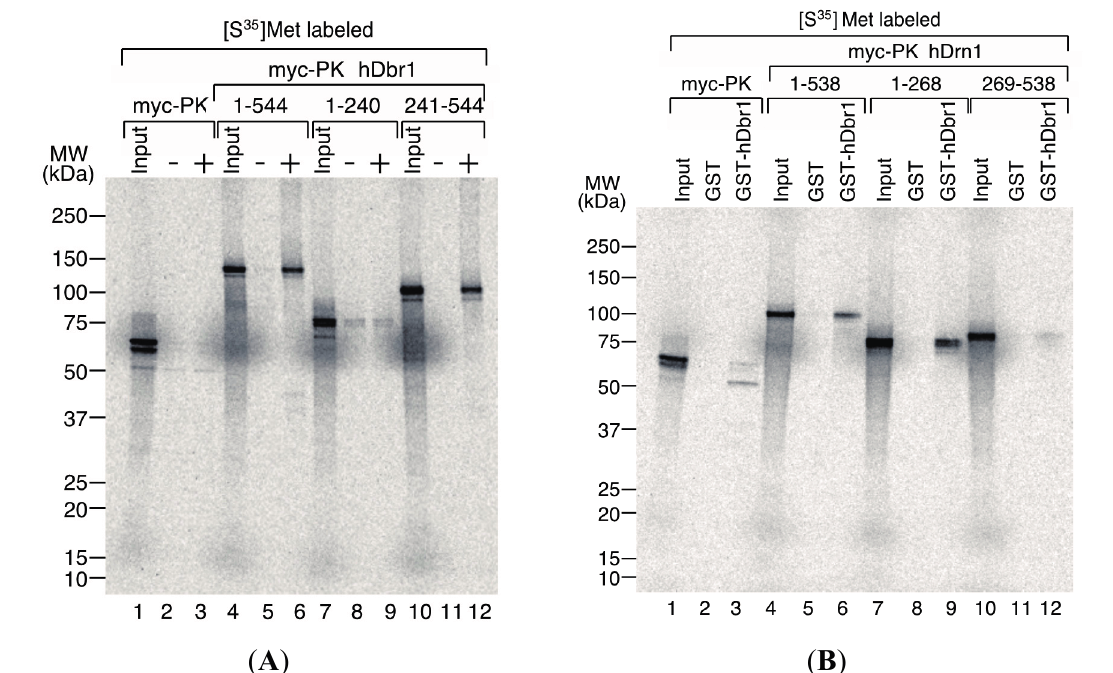
Figure 6. Determination of the interaction domains of hDbr1 and hDrn1. ( A ) 2 μ g of T7-His-hDrn1 proteins were incubated with in vitro translated myc-PK, myc-PK hDbr1 (aa. 1–544), myc-PK hDbr1 (aa. 1–240) and myc-PK hDbr1 (aa. 241–544). After washing, bound proteins were eluted, separated on 5%–20% gradient SDS-PAGE and visualized by fluorography. Input lanes contain 5% of the total protein used in each binding experiment. The positions of protein molecular mass markers are shown on the left of the panel; and ( B ) In vitro translated myc-PK, myc-PK hDrn1 (aa. 1–538), myc-PK hDrn1 (aa. 1–268) and myc-PK hDrn1 (aa. 269–538) were incubated with 5 μ g of either GST alone or GST-hDbr1. The bound proteins were analyzed and visualized as in ( A ). Input lanes contain 5% of the total protein used in each binding experiment. The positions of protein molecular mass markers are shown on the left of the